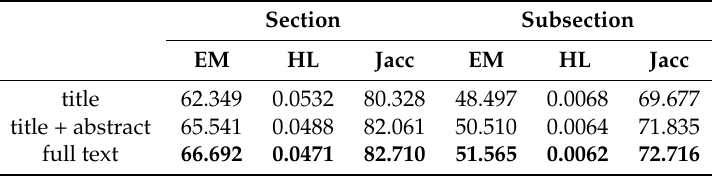
Table 7. Comparisons on selecting part of USPD validation